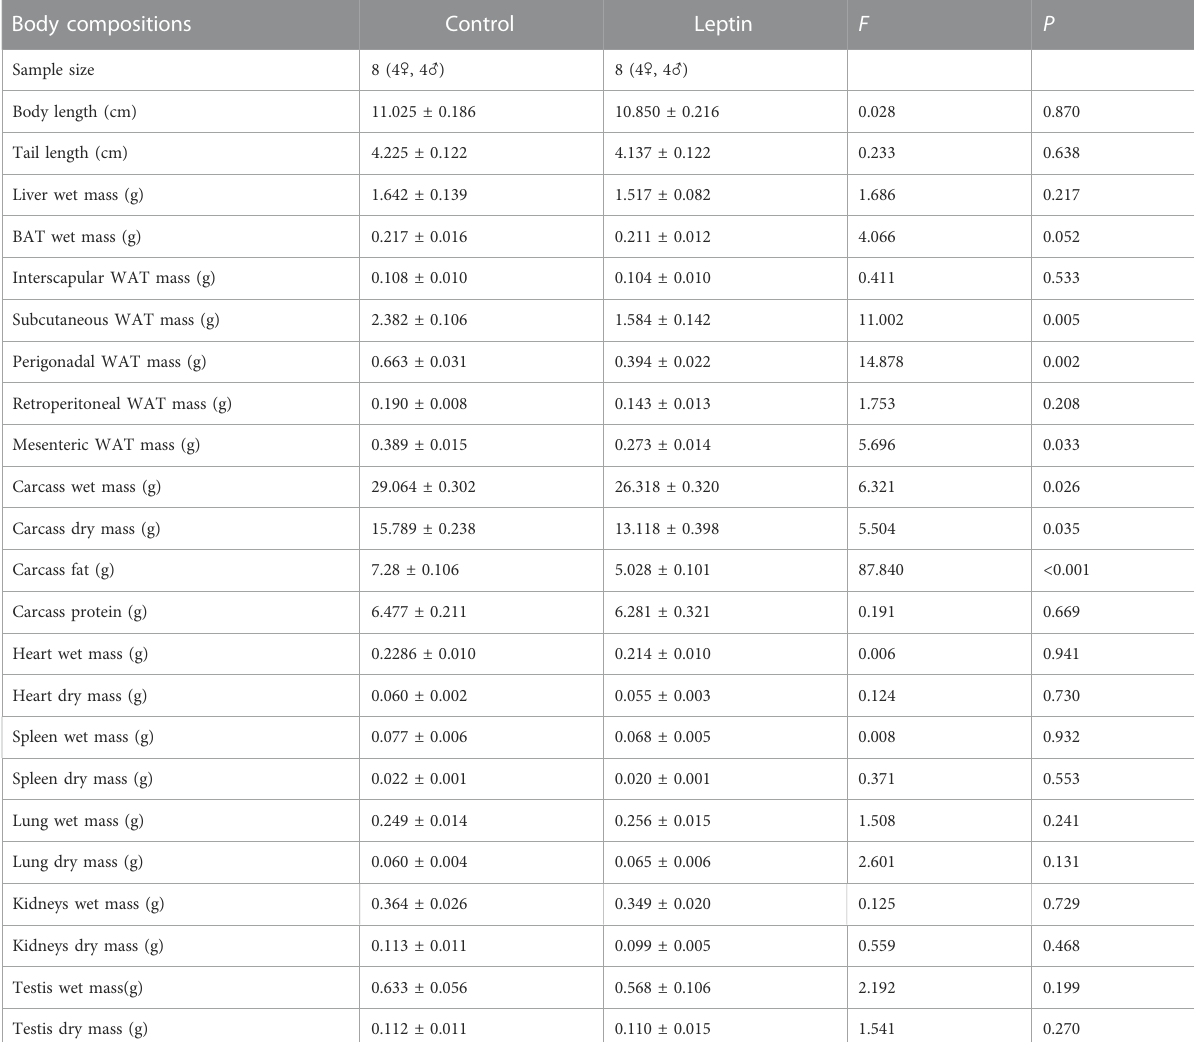
TABLE 1 Effects of leptin on body composition in Eothenomys miletus